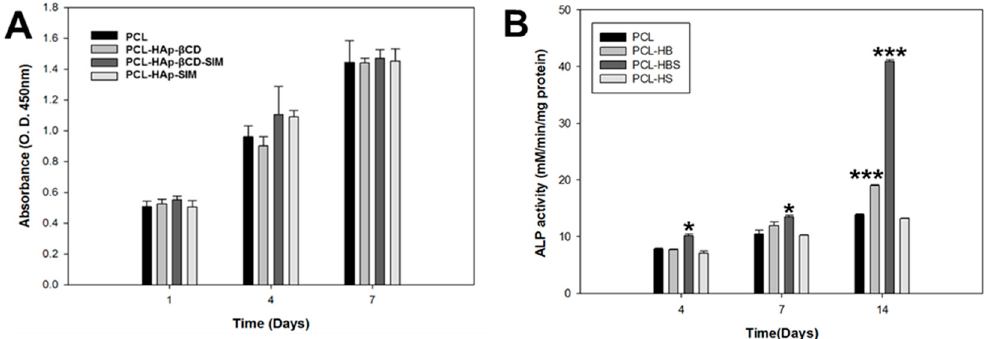
Figure 5. Human adipose-derived stem cell (hADSC) ( A ) proliferation and ( B ) alkaline phosphatase (ALP) activity on poly( ɛ -caprolactone) (PCL) scaffolds. (ALP) activity on poly( ε -caprolactone) (PCL)